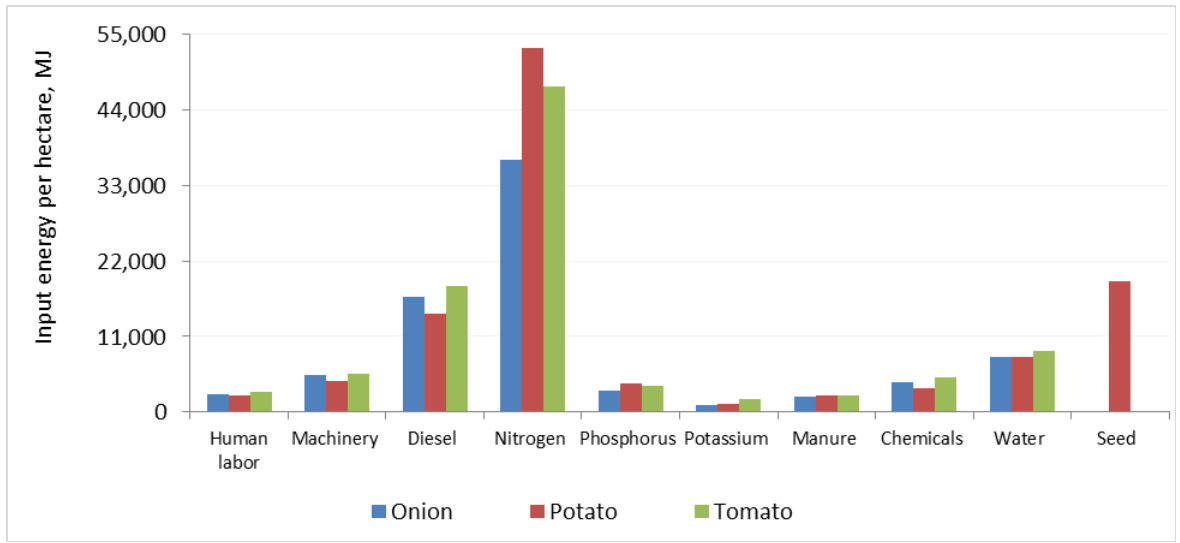
Figure 3. Amount of consumed energy used for one-hectare